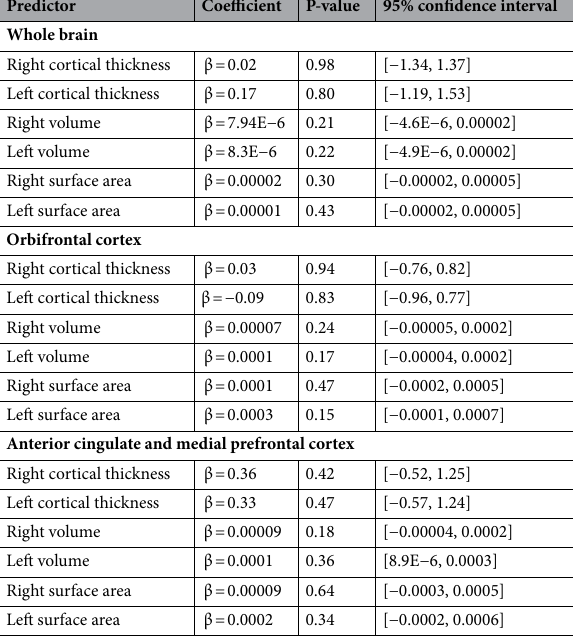
Table 3. Results for longitudinal effects of brain parameters at SHIP-2 on BMI at SHIP-3. Analyses are adjusted for ICV, age_2, sex, age*sex interaction, BMI at SHIP-2 and follow-up time, volume refers to GMV.